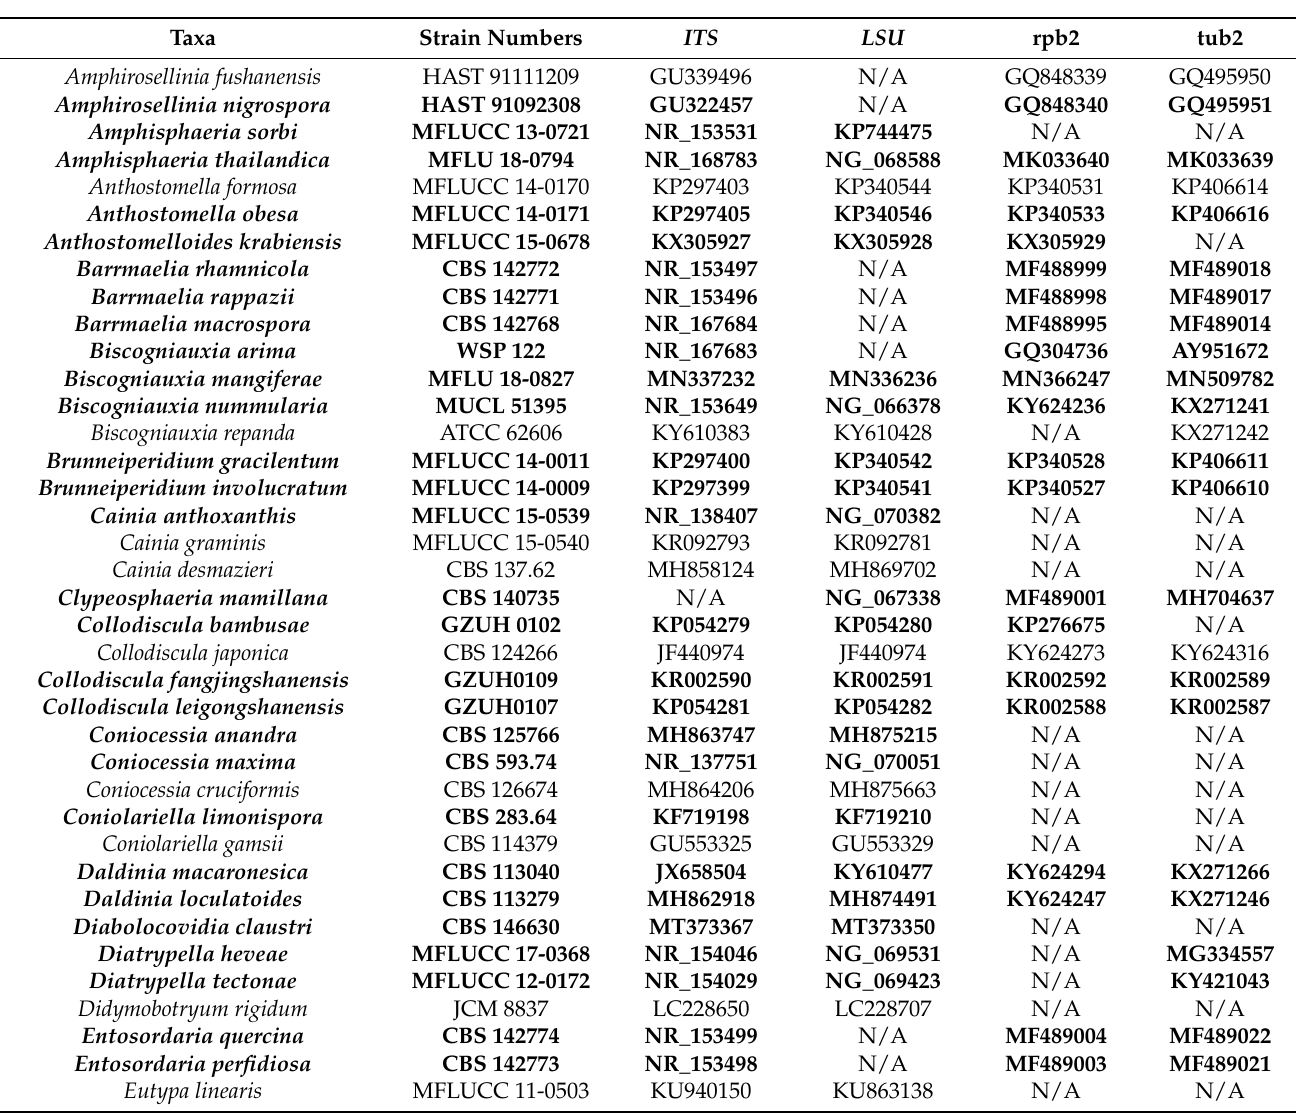
Table 2. Taxa names, strain numbers and corresponding sequences used for the molecular phylogenetic analyses.